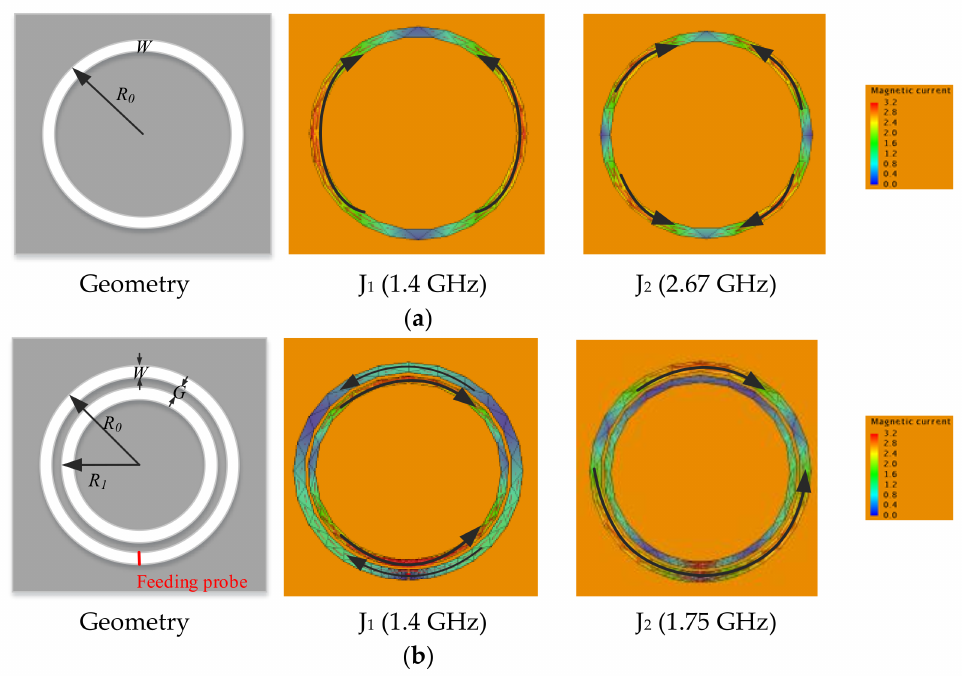
Figure 5. Sing-ring/double-ring slot antenna with R 0 = 32.3 mm, W = 3 mm, R 1 = 28.3 mm, G = 1 mm, and corresponding characteristic magnetic current distribution of two typical